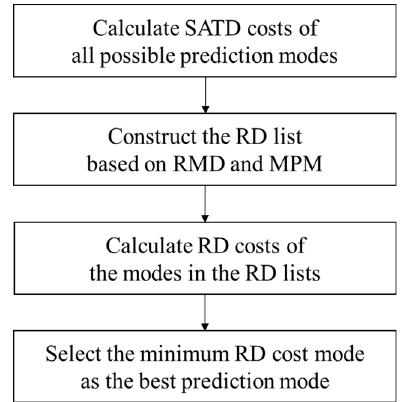
Figure 3. Flowchart of the intra prediction mode decision process.